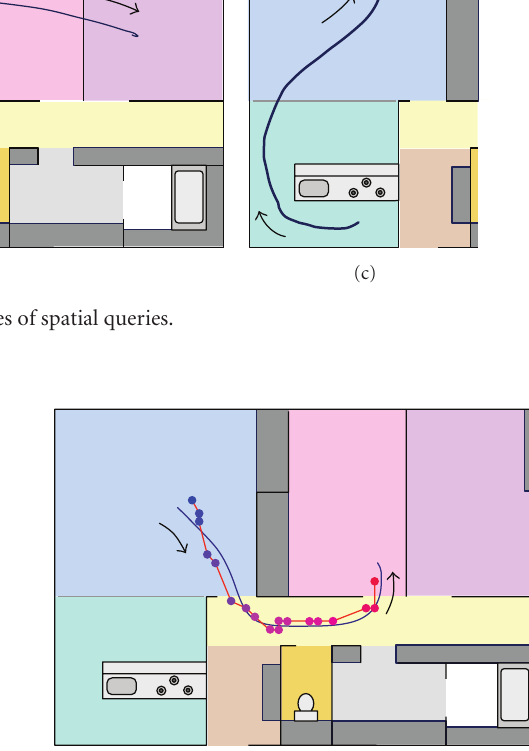
Figure 3: A search query of type 3, with the best matching